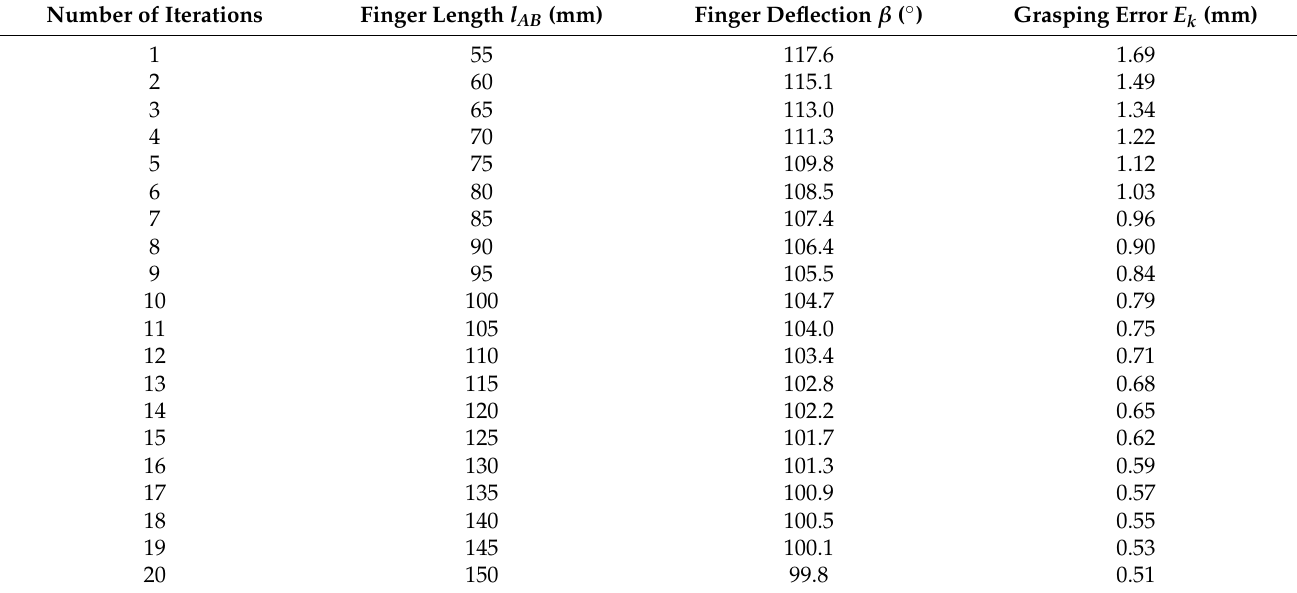
Table 2. Calculation results of the finger parameters and grabbing error.